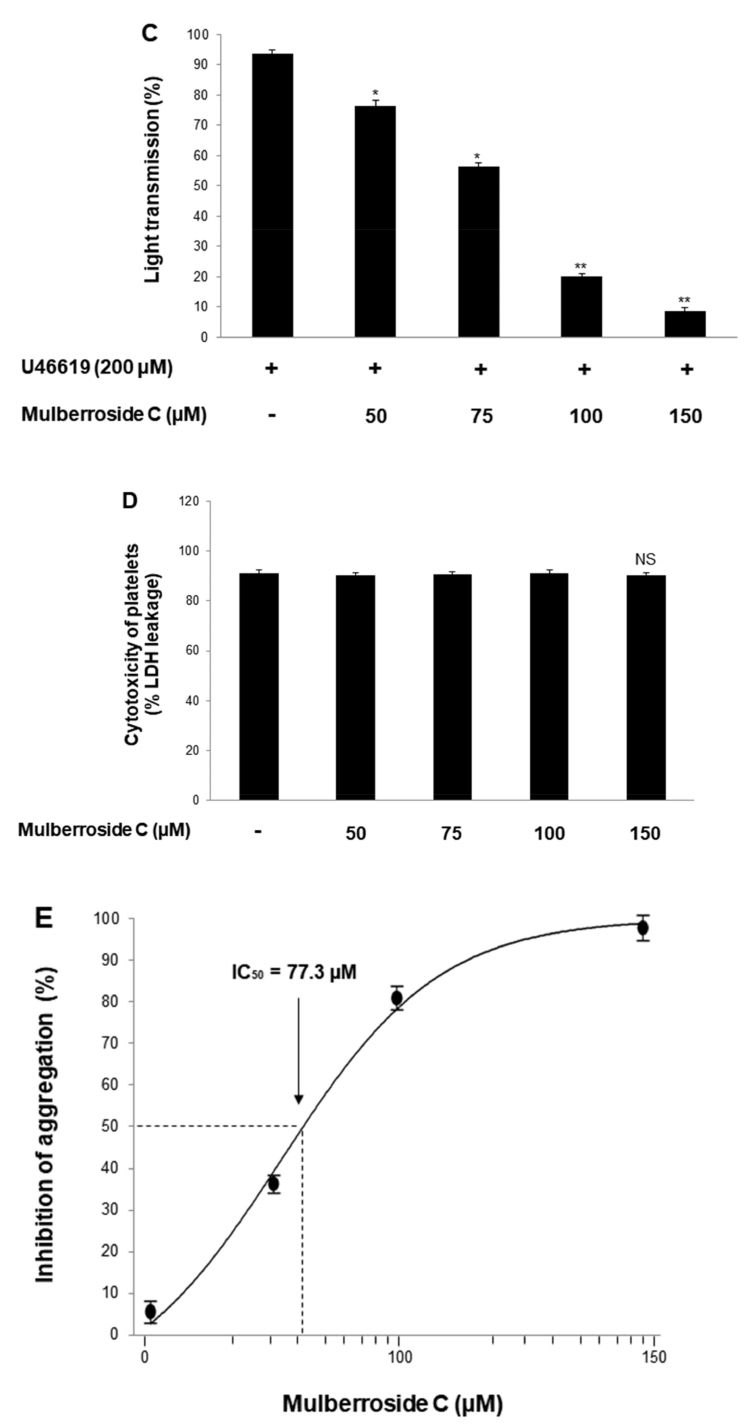
Figure 2. Effects of mulberroside C on platelet aggregation, half-maximal inhibitory concentration, and cytotoxicity ( A ) Effect of mulberroside C on collagen-induced human platelet aggregation; ( B ) Ef- fect of mulberroside C on thrombin-induced human platelet aggregation; ( C ) Effect of mulberroside C on U46619-induced human platelet aggregation; ( D ) Effect of mulberroside C on cytotoxicity; ( E ) Half-maximal inhibitory concentration (IC 50 ) value of mulberroside C in collagen-induced human platelet aggregation. Platelet aggregation and cytotoxicity were carried out as described in Section 2. The data are expressed as the mean ± standard deviation ( n = 4). * p < 0.05, ** p < 0.01 versus each agonist-stimulated human platelets. NS, not